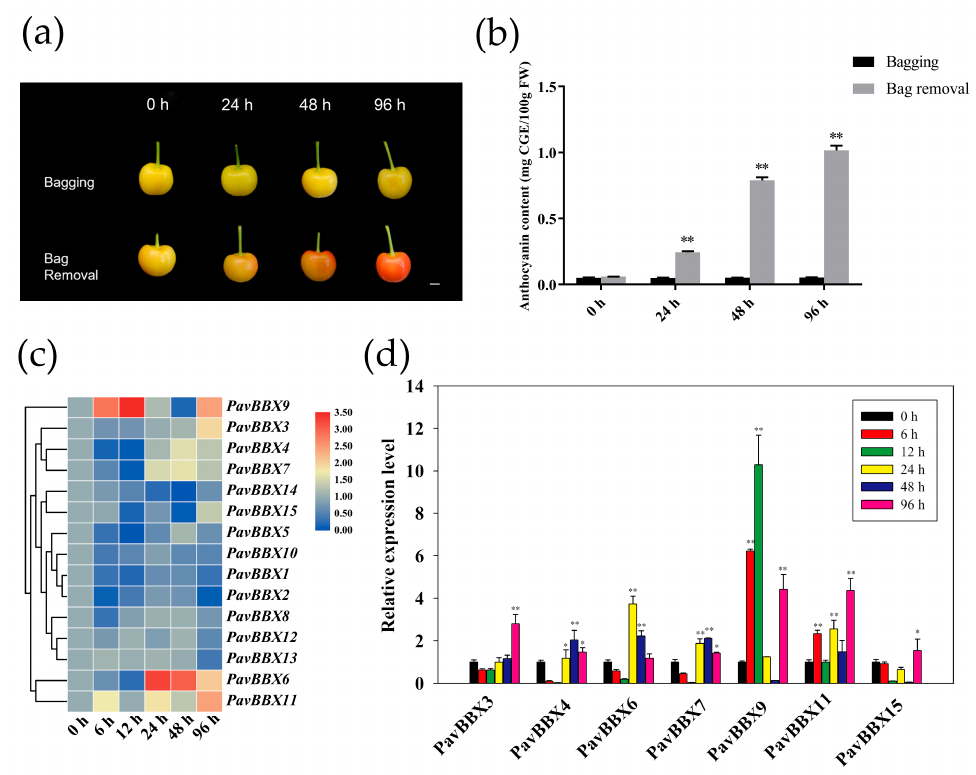
Figure 5. Expression profiles of PavBBX genes in ‘Rainier’ fruit following light induction via bag removal. ( a ) Color changes of ‘Rainier’ fruits after bag removal. Scale bars represent 1 cm. ( b ) Changes in anthocyanin content. ( c ) Hierarchical clustering of the expression profiles of 15 PavBBX genes after bag removing. ( d ) RT-qPCR analysis of seven selected PavBBX genes following light induction. PavActin was used as the internal reference control to normalize template levels. The relative mRNA levels are represented as the mean ± SD (n = 3). Statistically significant differences were assessed using Student’s t -test (* p < 0.05, ** p < 0.01).